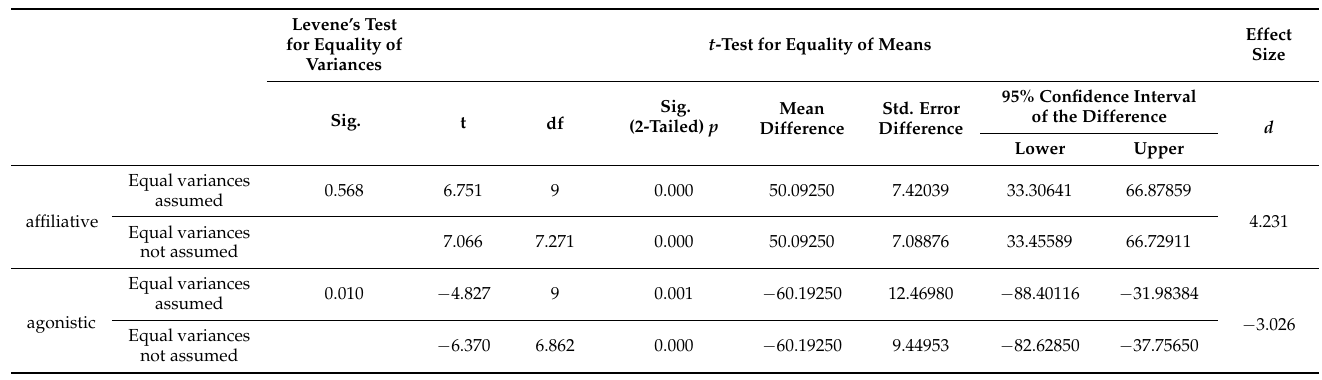
Table 5. Significances for affiliative and agonistic behaviours for related and unrelated elephants on behaviour during (re)unifications.